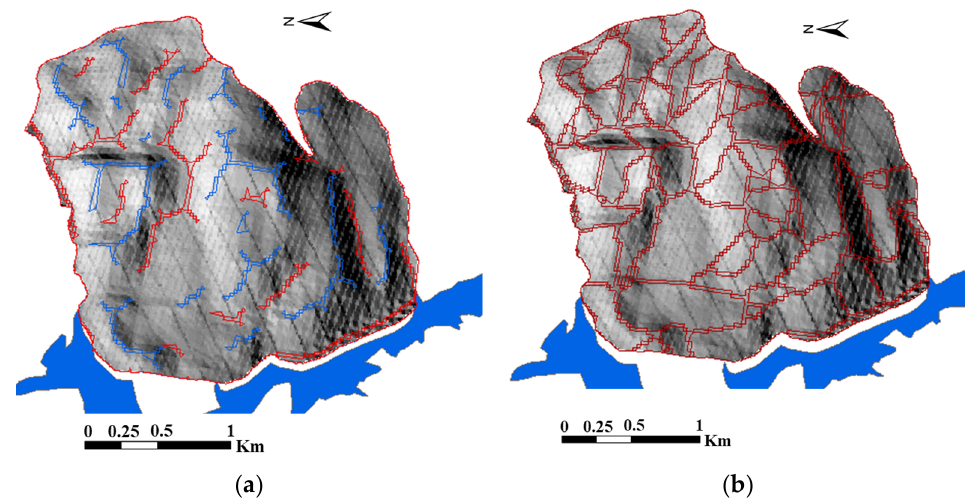
Figure 15 . The slope unit extraction process of MIA-HSU method of Jijing landslide: ( a ) morphological skeleton of valleys and ridges over shaded relief and ( b ) closed morphological skeleton network in which each small region contains homogenous geomorphological features.